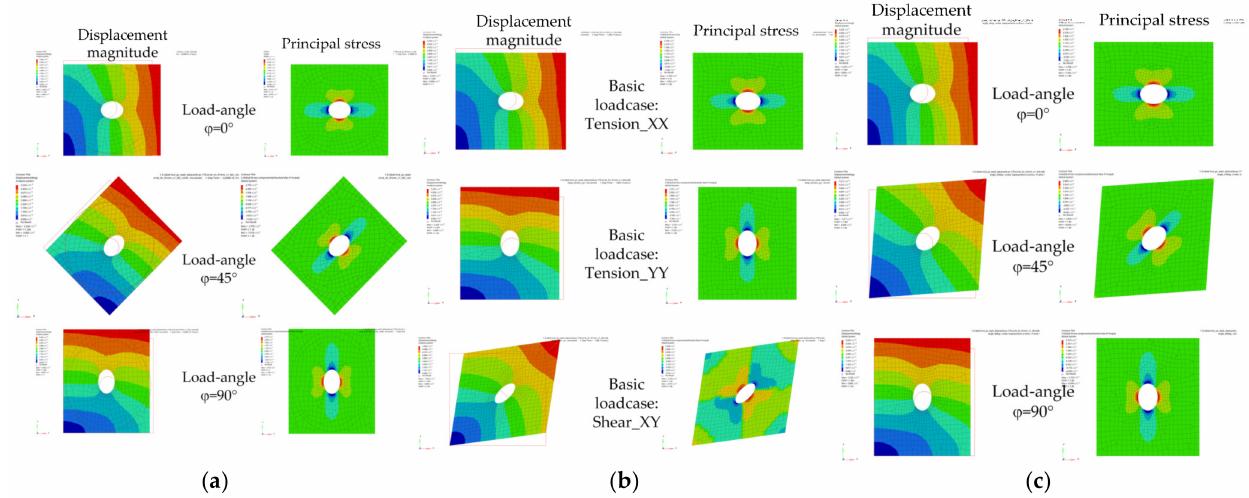
Figure 6. Displacement magnitude and principal stress results for different load angles ϕ (circu- lar hole-in-plate; mesh ‘circle_lin_R1mm_v1’): ( a ) Sub-case approach; ( b ) Basic load cases; and ( c ) Superposition of derived basic load